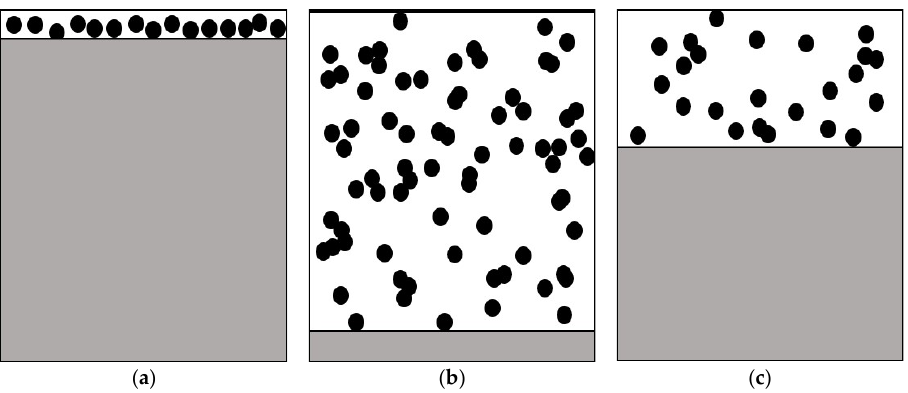
Figure 1. Basic phase characteristics of chloride molten salt system: ( a ) bubble point state; ( b ) dew point state; and ( c ) flash equilibrium state.